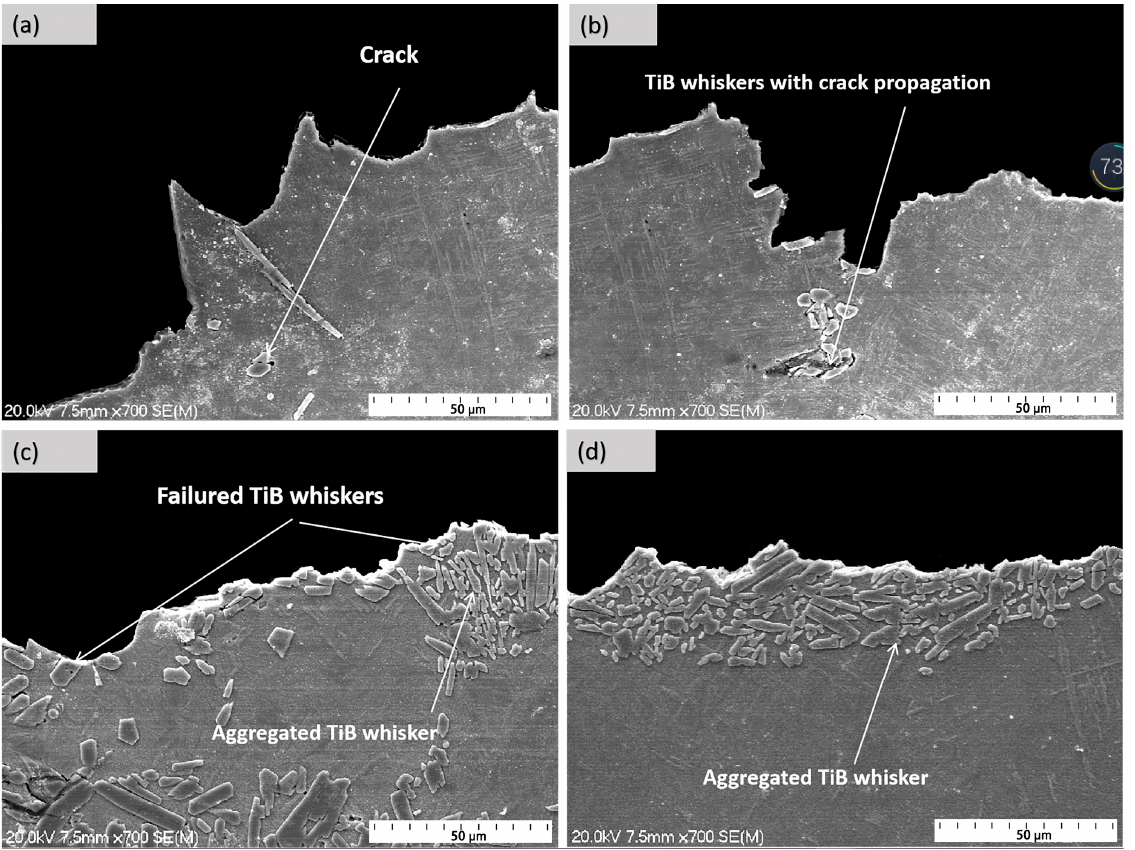
Figure 11. SEM images of the longitudinal sections of tensile test samples cut from different samples: ( a ) Chips-Ti64-1TiB; ( b ) Chips-Ti64-3TiB; ( c ) Chips-Ti64-5TiB; and ( d ) Chips-Ti64-7TiB.